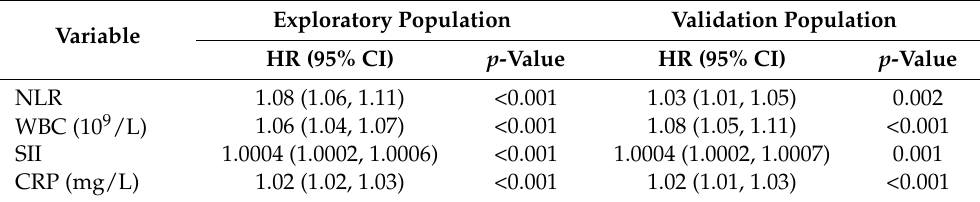
Table 2. Association between biomarkers of inflammation and 30-day